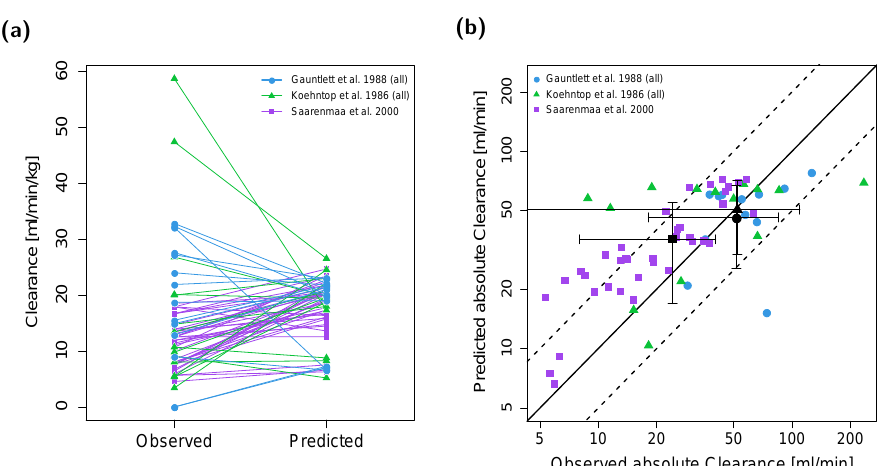
Figure 7. Predicted and observed clearance per bodyweight ( a ) as well as predicted versus observed absolute clearance values for the pediatric PBPK model ( b ). Each colored symbol represents the individual clearance of a patient; black symbols represent the mean clearances with standard deviations (circles refer to data from Gauntlett et al. [36]; triangles refer to data from Koehntop et al. [37]; squares refer to data from Saarenmaa et al. [38]). In ( b ), the black solid line marks the line of identity; black dashed lines indicate 2-fold